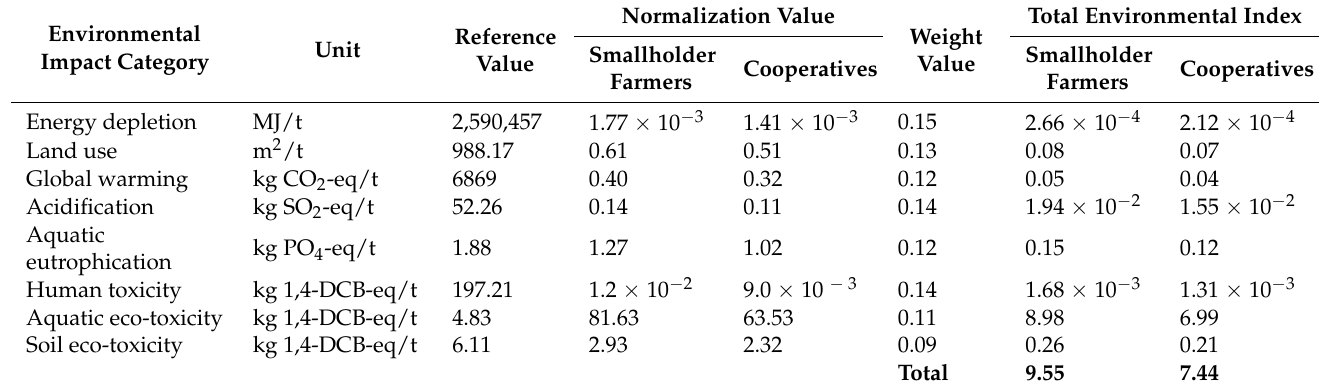
Table 6. Normalization and weighting of per ton of apple production in environmental